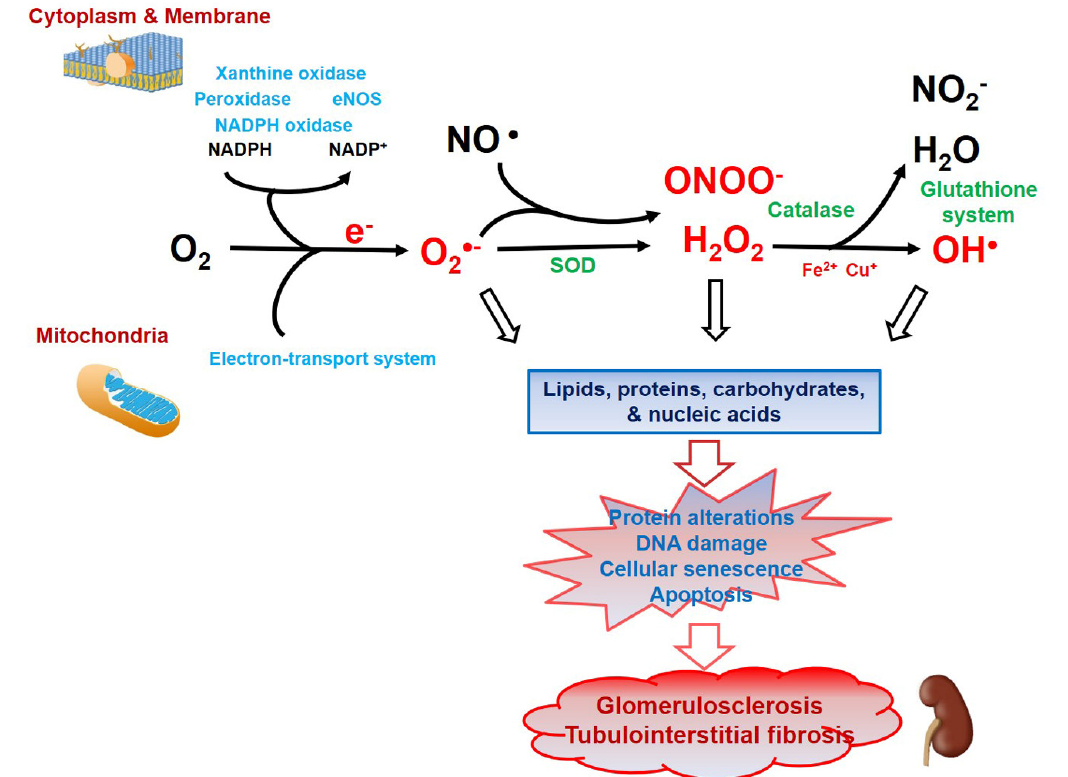
Figure 1. Schematic overview of endogenous sources of oxidative stress and antioxidative reactions in renal damage. Ex- ogenous (environmental factors such as air and water pollution, smoking, drugs, and radiation) and endogenous (normal metabolic processes in living organisms) sources of oxidative stress produce reactive oxygen species (ROS). Endogenously, ROS are generated as products of biochemical reactions in the mitochondria (electron-transport system; ETS), plasma membrane, cytoplasm (including peroxisomes and lysozymes), and the membrane of the endoplasmic reticulum. The mitochondrial ETS, adenine dinucleotide phosphate (NADPH) oxidase, xanthine oxidase, myeloperoxidase, and endothe- lial nitric oxide synthase (eNOS) are the main sources of cellular ROS formation. An important reaction in free radical formation is the Fenton and Fenton-like reactions to produce ROS in which Fe 2+ and Cu + react with H 2 O 2 to form OH  , respectively. To protect and repair the molecular injury caused by ROS, cells use a defense system composed of enzymatic antioxidants, including superoxide dismutase (SOD), catalase, and peroxidase, and nonenzymatic antioxidants made by the glutathione system. The main site of O 2•− generation is the inner mitochondrial membrane during ETS-processes. The decomposition of H 2 O 2 into water and oxygen is done by SOD, the glutathione system, and catalase, in that order. Excess ROS causes lipid peroxidation, nitro-oxidation, glyco-oxidation, and oxidative DNA damage, which can together cause protein alterations, DNA damage, cellular senescence, and apoptosis. All of those changes eventually lead to glomerulo- sclerosis and tubulointerstitial